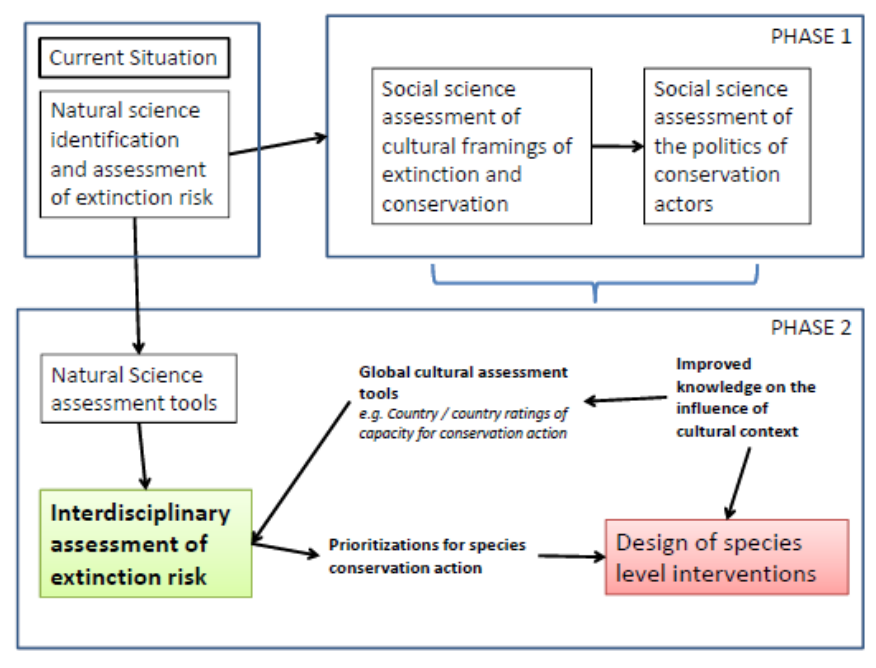
Figure 2. Schematic of proposed protocol for a phased implementation of an applied biocultural theory of avoided extinction to improve prioritization procedures (redrawn from